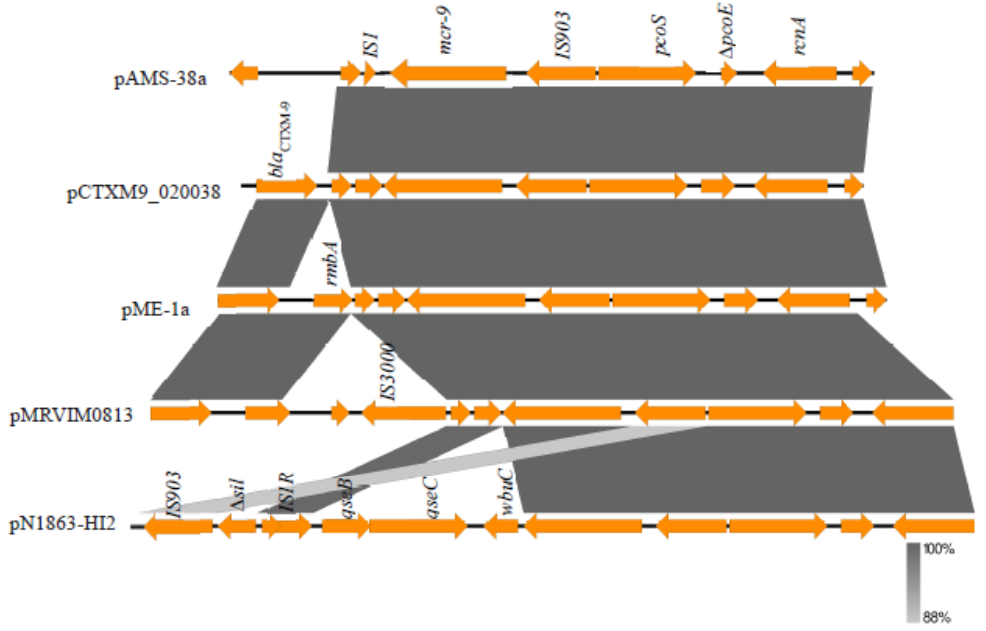
Figure 2. Comparison of the genetic environment of mcr-9 gene in pAMS-38a and other closely related IncHI2 plasmids. The figure was drawn using the EasyFig tool. Two different genetic environments have been detected. IS 1 - mcr-9 -IS 903 was detected from pAMS-38a (identified in this study), pME-1a (CP041734), pCTXM9_020038 (CP031724), pMRVIM0813 (KP975077) , and qseB - qseC - wbuC - mcr-9 -IS 903 was detected from pN1863-HI2 (MF344583).